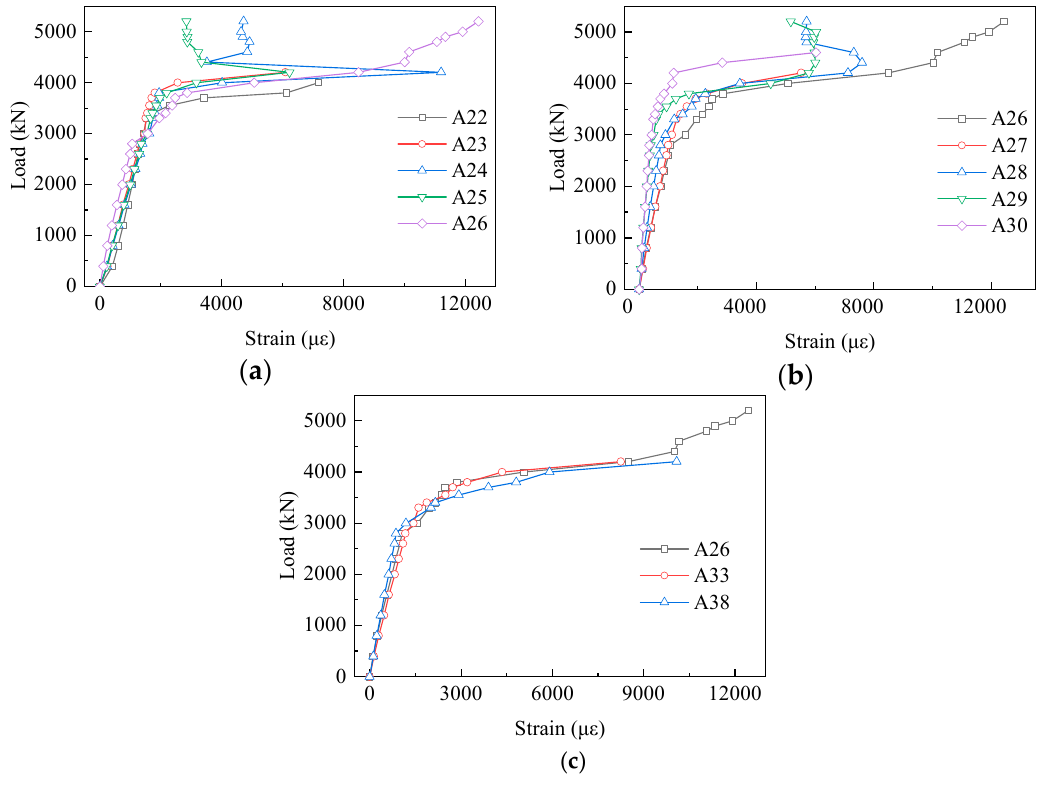
Figure 10. Load–strain curves of the exposed gusset plates: ( a ) A22 to A26 in the fourth row; ( b ) A26 to A30 in the fourth row; and ( c ) A26 to A38 in the middle column.